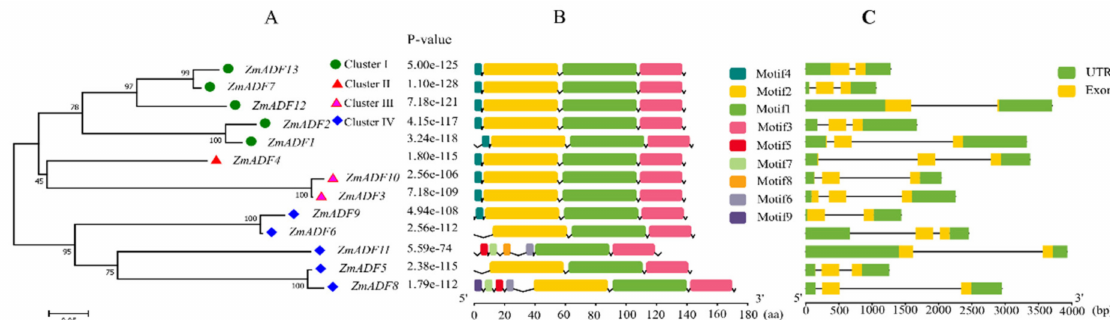
Figure 3. Conserved motifs and gene structure of the ZmADFs according to phylogenetic relationships. ( A ) The rootless neighbor-joining tree was constructed using MEGA7.0 program with the complete amino acid sequences of the 13 maize ADF proteins; ( B ) Conserved motif distribution map of the ZmADF gene. The 9 predicted motifs are represented by di ff erent colored boxes; (C) Exon and intron structure analyses of ZmADF genes were performed by TBtools. The green boxes, yellow boxes, and the black lines indicate UTRs region, exons, and introns, respectively. The length of the amino acid and exon and intron can be inferred by the ruler at the